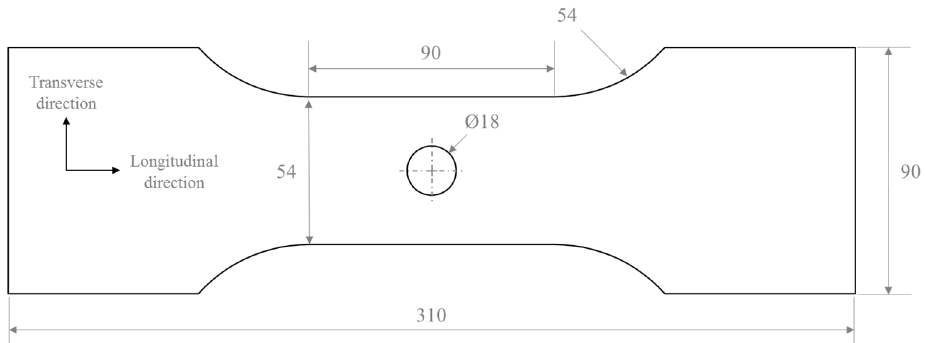
Figure 1. Sample design. Units are specified in mm.